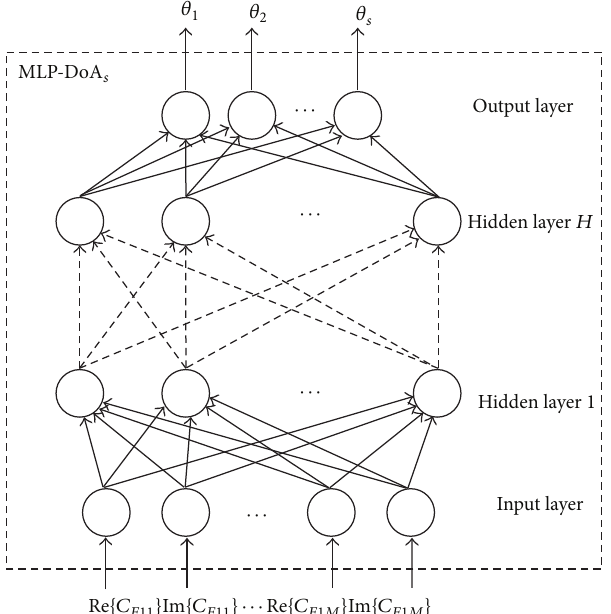
Figure 4: MLP-DoA network for estimation of angular position of 𝑠 stochastic sources in the azimuth